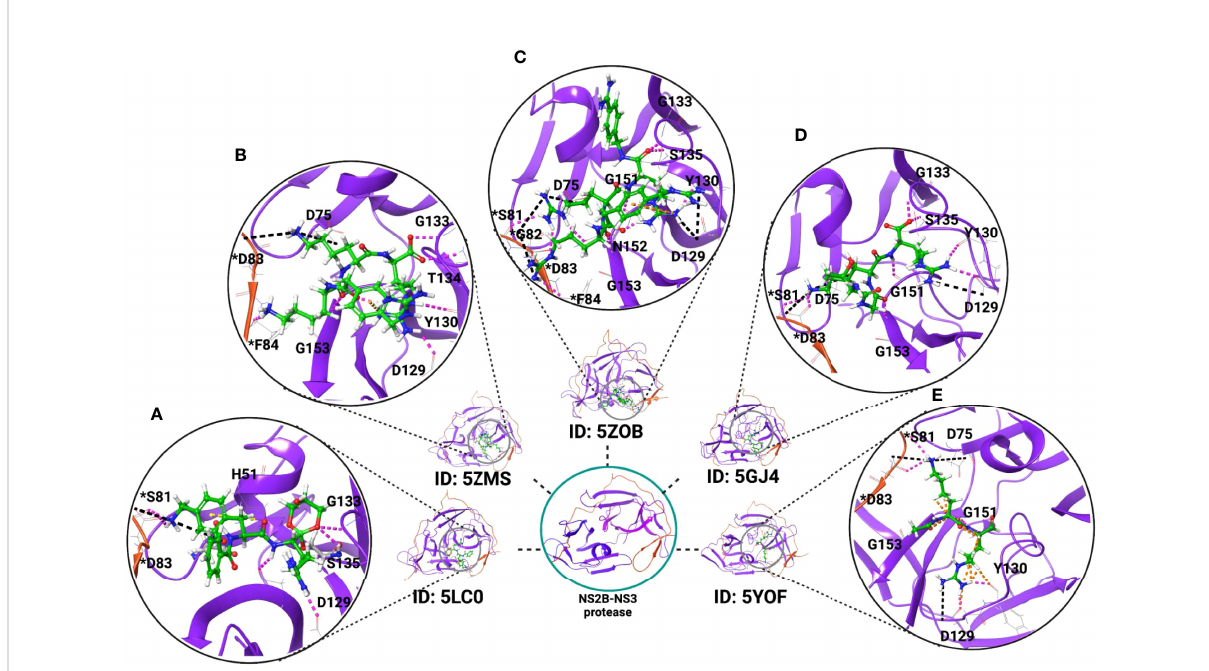
FIGURE 1 Crystal structure of ZIKV NS2B-NS3 protease in complex with inhibitors. These inhibitors reduce the protease activity and may block polyprotein cleavage in the host cells and could be potential inhibitors of ZIKV if tested in mammalian cells. Examples include the X-ray crystal structures of the NS2B-NS3 protease in complex with (A) the boronate inhibitor cn-716 (PDB ID: 5LC0); (B) 4-guanidinomethyl-phenylacetyl-Lys-Lys-Arg-H (PDB ID: 5ZMS); (C) 4-guanidinomethyl-phenylacetyl-Arg-Arg-Arg-4-amidinobenzylamide (PDB ID: 5ZOB); (D) Thr-Gly-Lys-Arg, tetrapeptide of NS2B C-terminal (PDB ID: 5GJ4); and (E) dipeptide inhibitor (PDB ID: 5YOF). Residues with an asterisk are from NS2B (red-colored ribbon), and residues without an asterisk are from NS3 protease (purple-colored ribbon). Inhibitors are represented in green